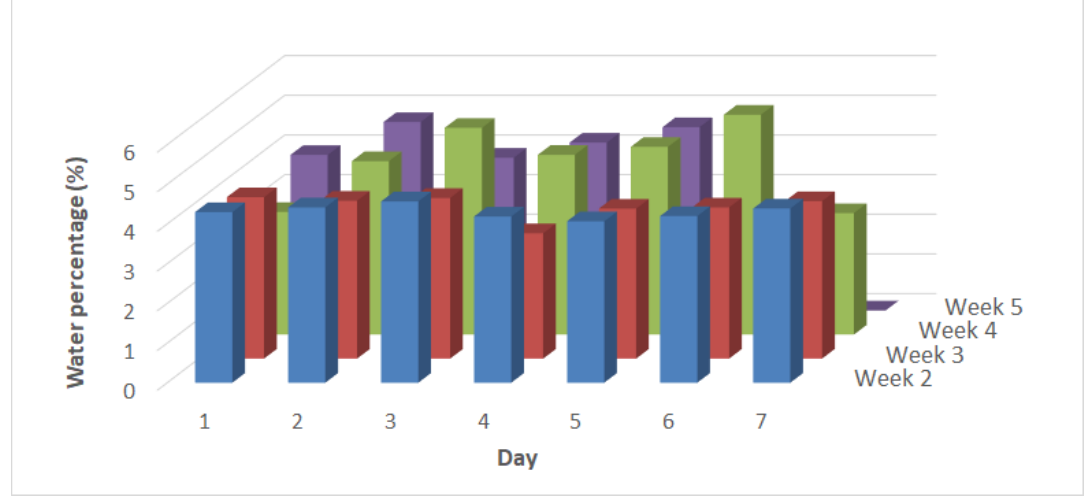
Figure 15. Daily evaporation (%).